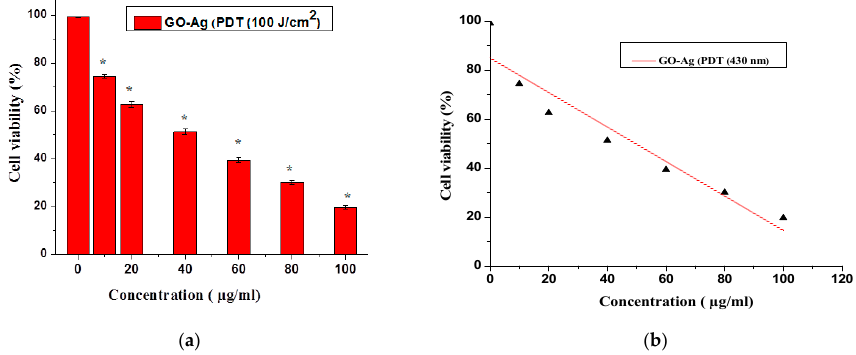
Figure 11. ( a ) Cellular viability of GO-Ag treated breast cell carcinoma using PDT (100 J/cm 2 ), t -test ( * p < 0.05); ( b ) Linear calibration Plot of GO-Ag vs. cell viability under PDT (100 J/cm 2 ).